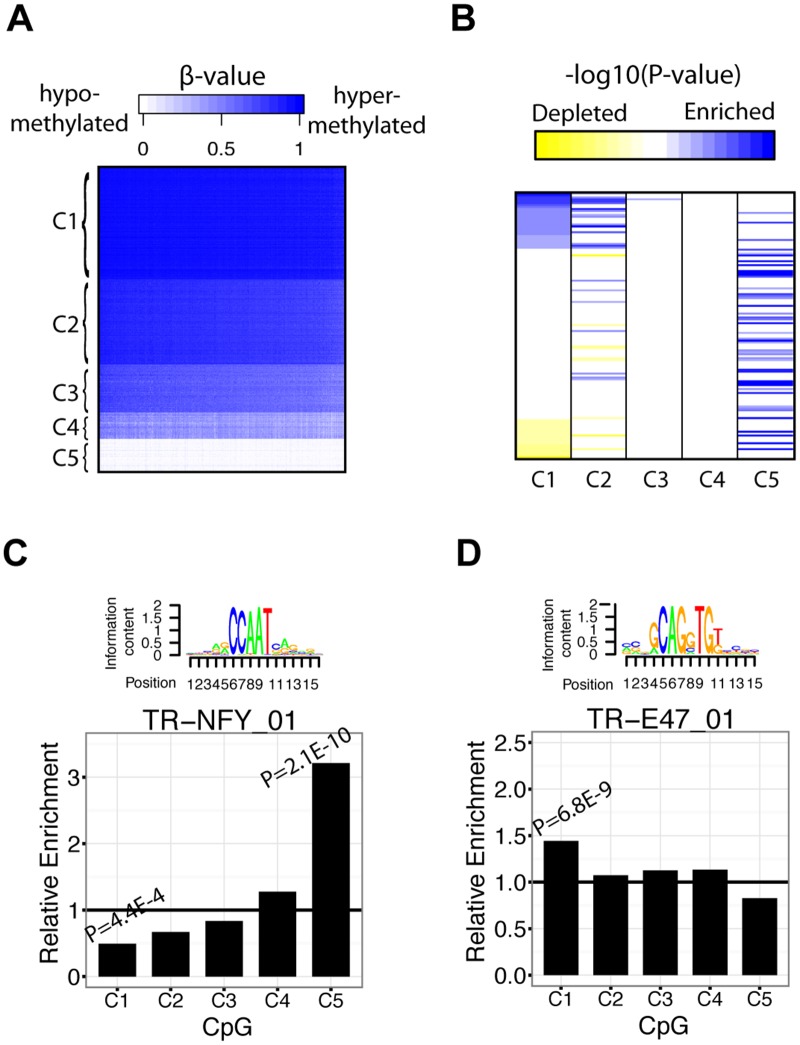
TF enriched in CpG subtypes of breast cancer.
A) K-means clustering of CpG β-values into 5 distinct clusters. B) Ordering of significantly enriched/depleted (P<0.05) TF binding motifs relative to their -log10(P-value) ordering in cluster 1 (column 1). All -log10(P-values) greater than 10 were set to 10 and all values less than 3 were set to 0. Enrichment of motifs is shown in blue and depletion is shown as yellow. C) Enrichment values of TR-NFY_01 in each CpG subtype (C1–C5) D) Enrichment values of TR-E47_01 in each CpG subtype (C1–C5).